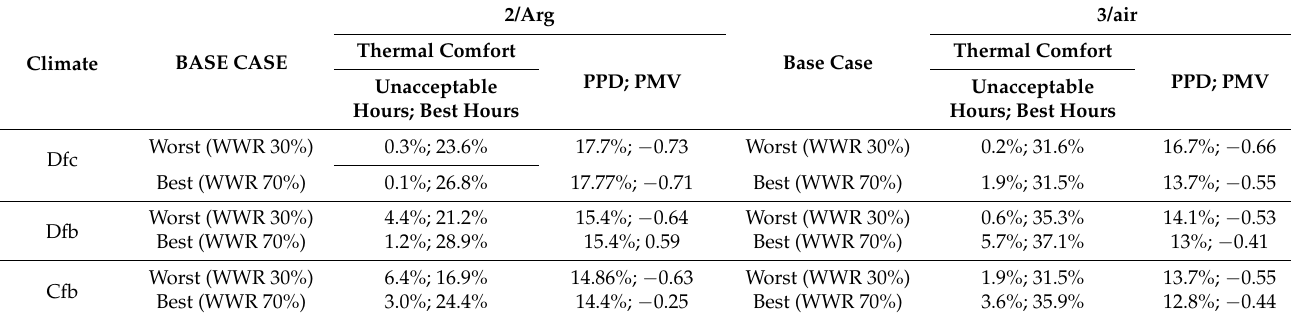
Table 5. Best and worst WWR based on thermal comfort analyses for cold climate conditions.